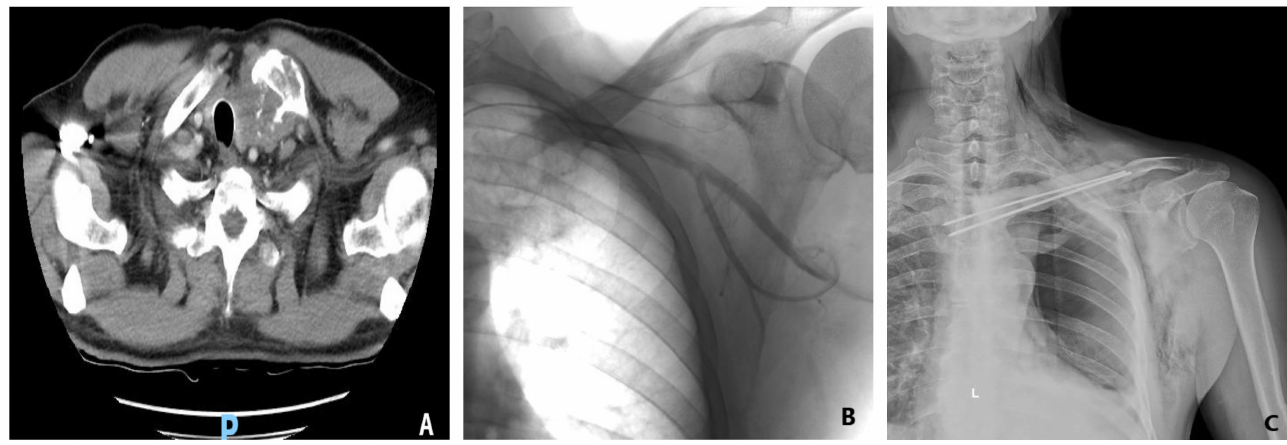
Figure 2. ( A ) Preoperative tomography of a 66-year-old male diagnosed with clavicle condrosarcoma. ( B ) Preoperative angiography and embolization of the tumor were performed prior to resection to limit intraoperative blood loss. ( C ) Postoperative image of acrylic cement reinforced with Kirschner brooches reconstruction used after tumoral